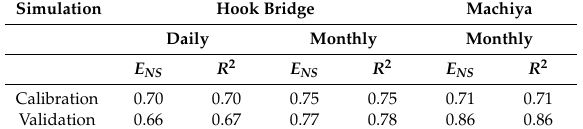
Table 3. Model performance ( E NS : Nash–Sutcliffe Efficiency and R 2 : Coefficient of determination). Simulation Hook Bridge Machiya